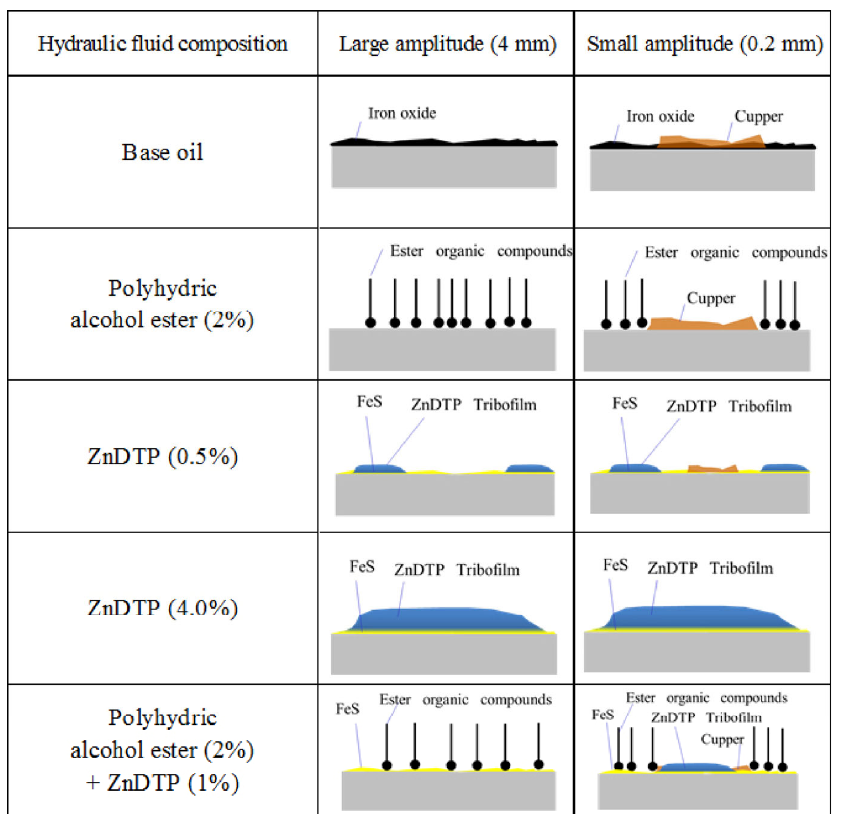
Fig. 12 Summary of the results of surface analysis after